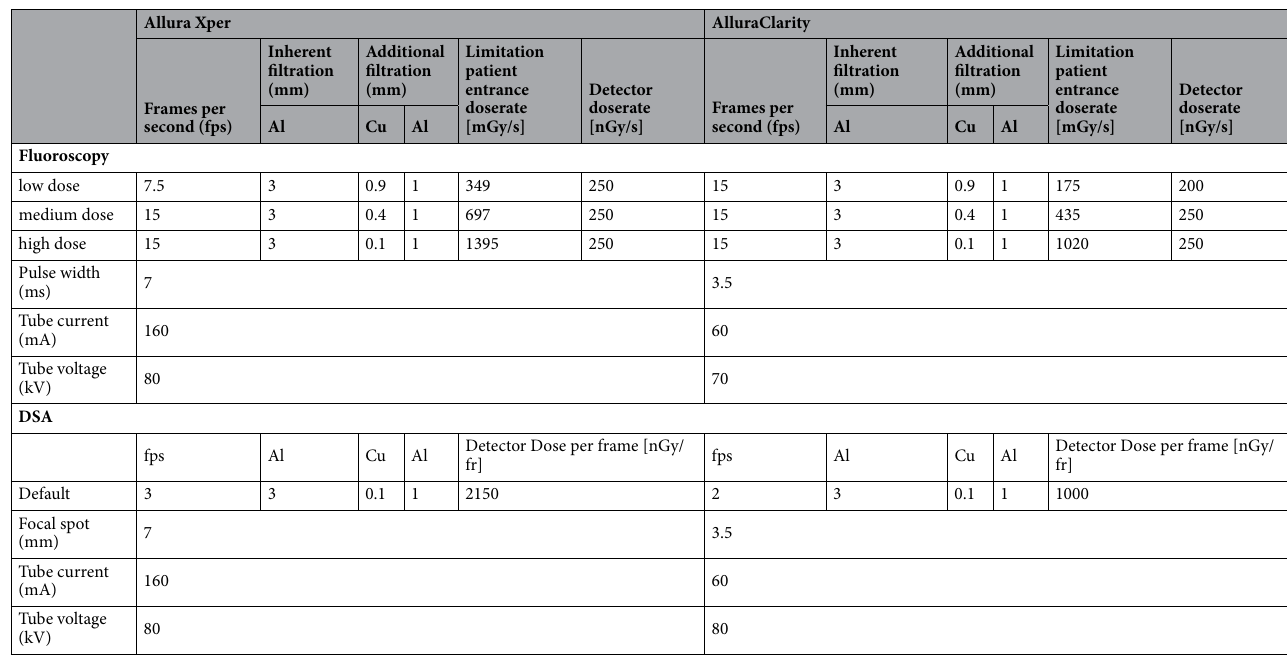
Table 2. Imaging settings for abdominal fluoroscopy and DSA.